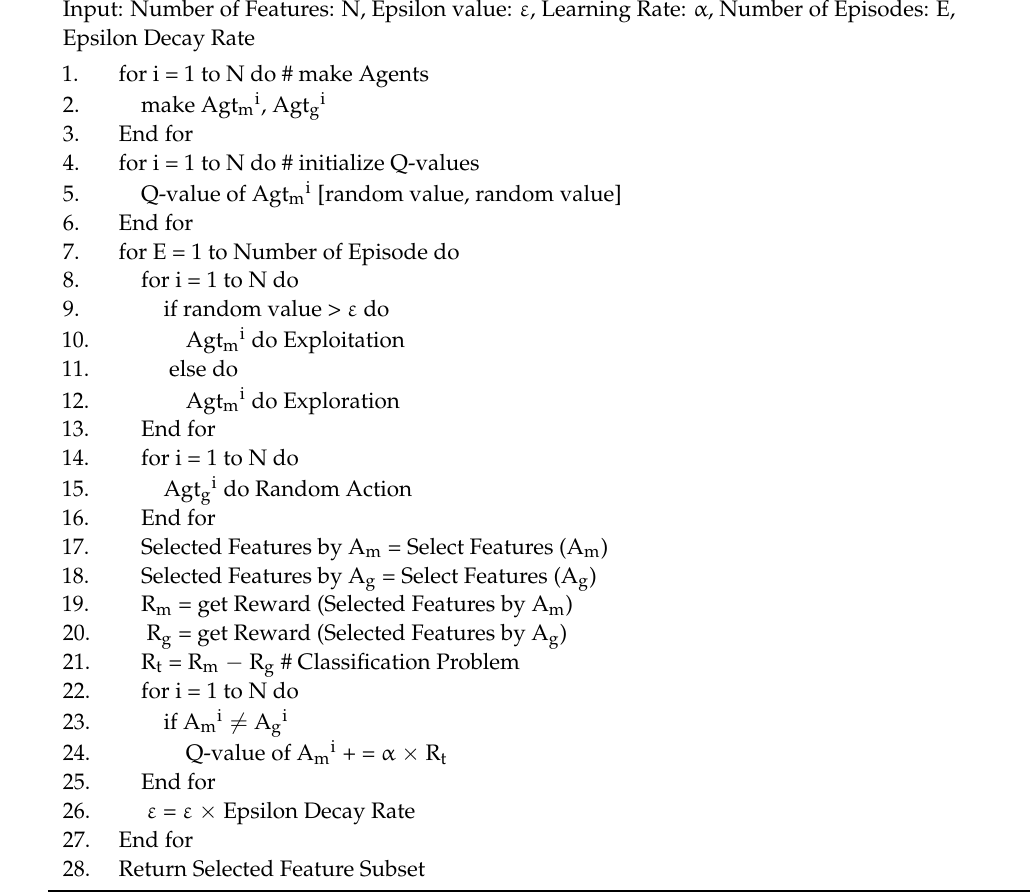
Algorithm 1: Multi-Agent Reinforcement Learning Feature Selection Method with Guide Agents